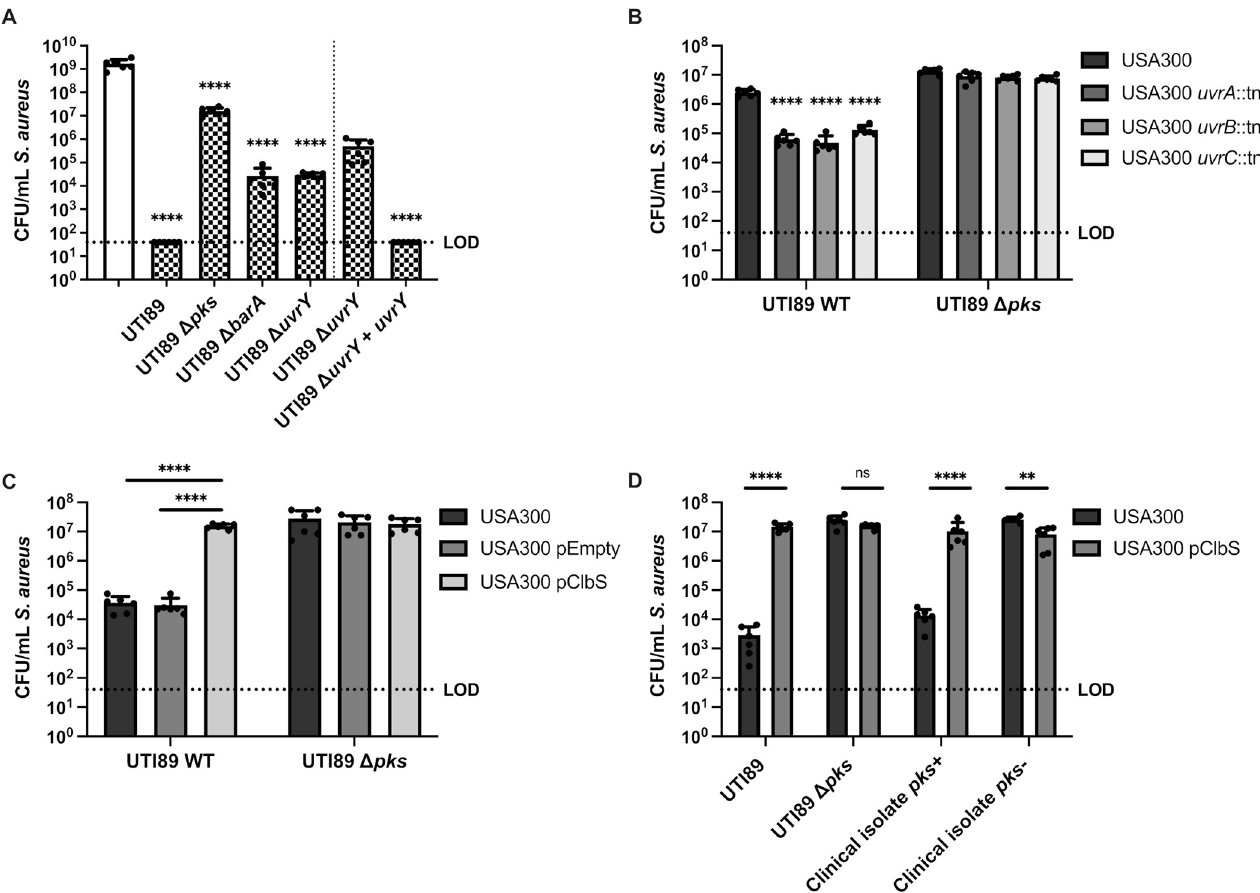
Fig 3. The BarA-UvrY two component system (TCS) and the pks island are required for E . coli -mediated killing of S . aureus . (A) Enumeration of S . aureus USA300 LAC and mixed (1 EC :1 SA ) macrocolonies with either UTI89 wild type, knockout mutants of the pks island, barA or uvrY or complemented strains. The vertical dotted line indicates that data collected on either side were collected from separate experiments. Data from single species macrocolonies are indicated with open bars, and data from mixed species macrocolonies are indicated with checked bars. N = 6 independent biological experiments. Statistical significance was determined by one-way ANOVA with Dunnett’s test for multiple comparison. (B) Enumeration of S . aureus USA300 LAC from 8 h macrocolonies. Wild type S . aureus USA300 LAC and uvrABC transposon mutants were mixed 1 EC :1 SA with either E . coli UTI89 or knockout mutants of the pks island. N = 6 independent experiments. (C) Enumeration of S . aureus from 24 h macrocolonies. Wild type S . aureus USA300 LAC was transformed with pJC-2343 (pEmpty) or pJC-2343-ClbS (pClbS) and mixed 1:1 with either E . coli UTI89 or knockout mutants of the pks island. N = 6 independent experiments. Individual data points are indicated with closed circles. (D) Enumeration of S . aureus from 24 h macrocolonies. Wild type S . aureus USA300 LAC or USA300 pClbS was mixed 1:1 with either E . coli UTI89, UTI89 Δ pks island, pks + or pks - clinical isolate. N = 6 independent experiments. (B-D) Statistical significance was determined by two-way ANOVA with Tukey’s test for multiple comparisons. ���� p < 0.0001, error bars represent SD from the mean. All statistical tests were performed on log-transformed CFU